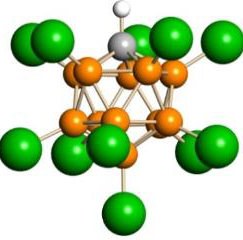
Figure 1. Undecachlorocarborane anion CHB 11 Cl 11 − (atoms: green Cl, brown B, grey С and white H) .